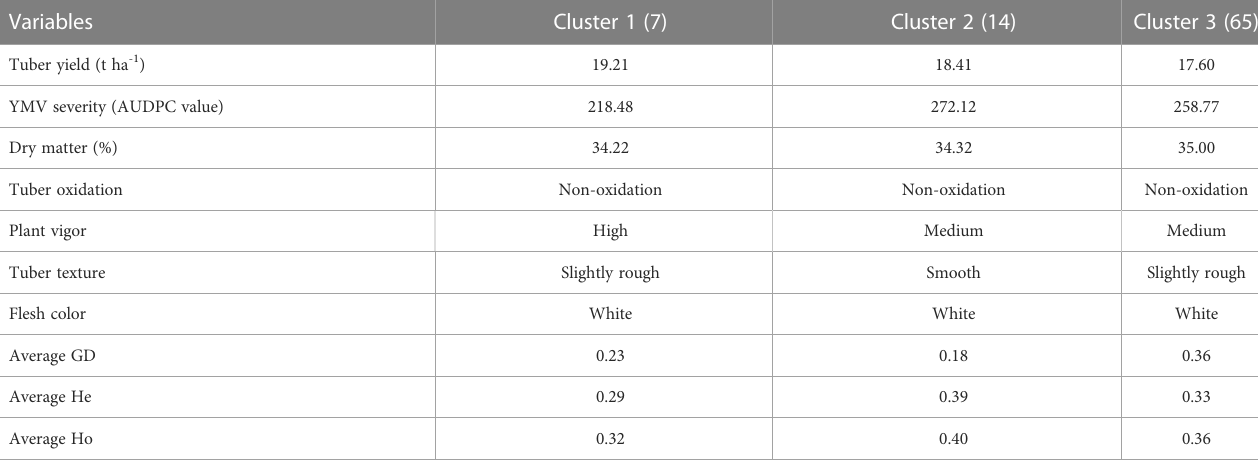
TABLE 3 Agronomic performance of farmers ’ landraces and genetic characteristics of clusters generated using SNP markers. Variables